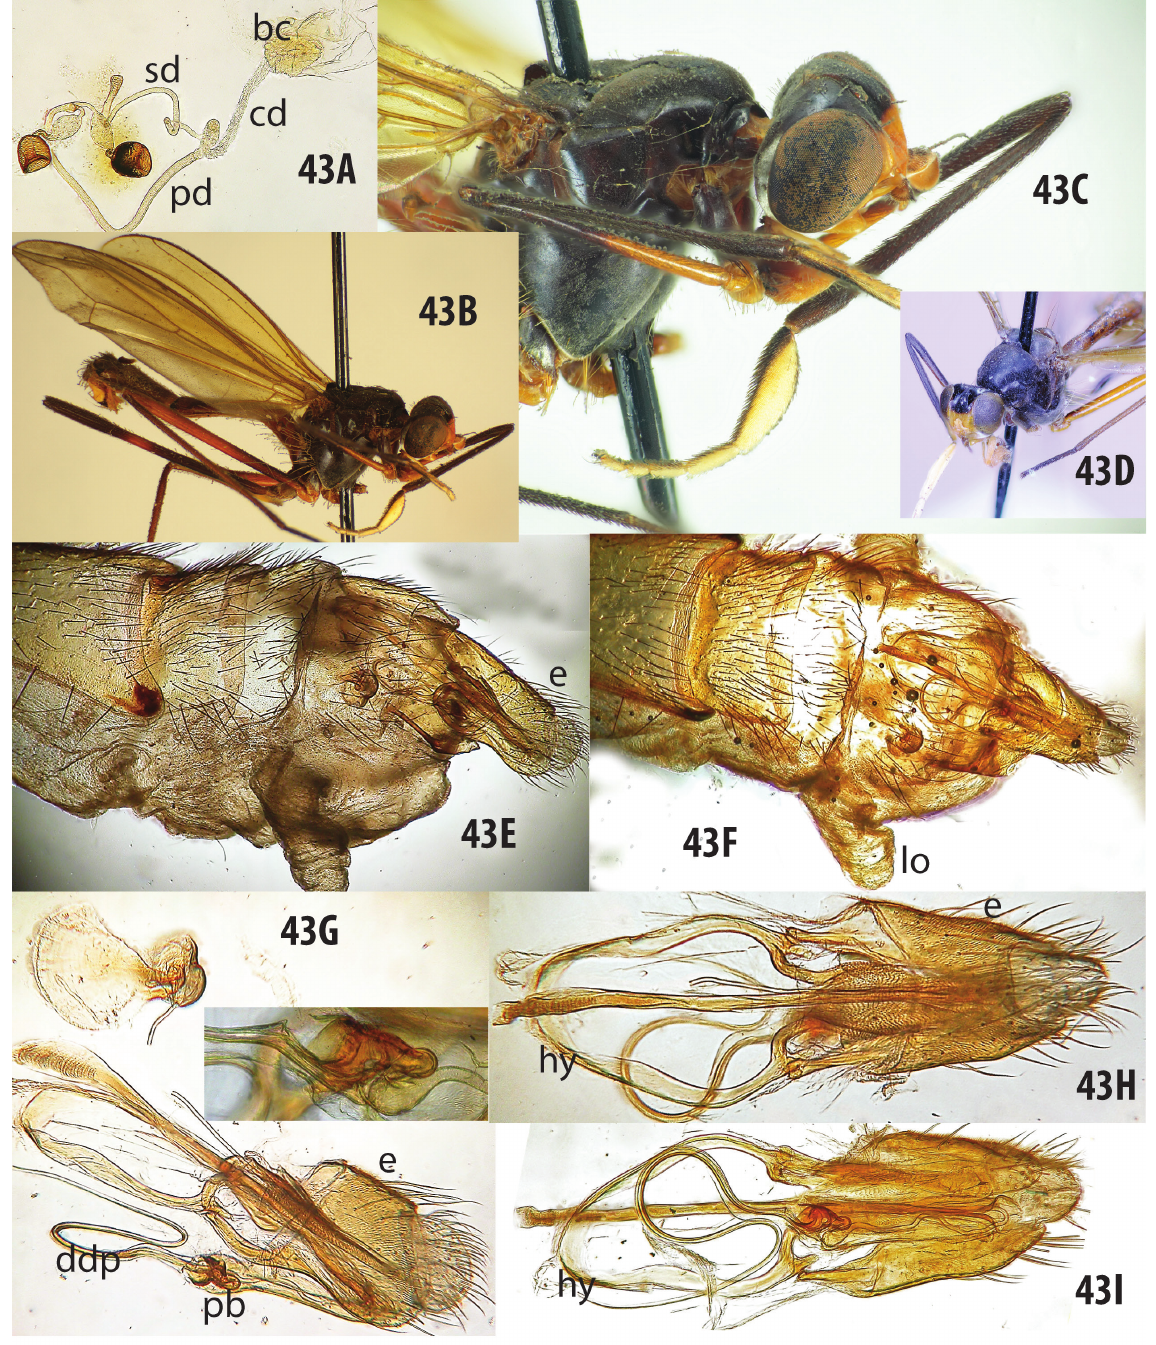
Fig. 43. Mesoconius lobopoda sp. nov. A . Spermathecae and associated structures. B–D . Holotype, ♂, BMNH. E . Abdomen, ♂, left side. F . Abdomen, ♂, ventral view. G . Male terminalia, lateral view, with phallic bulb enlarged in inset. H . Male terminalia, dorsal view. I . Male terminalia, ventral view. Abbreviations: bc = bursa copulatrix; cd = common spermathecal duct; ddp = distal distiphallus; e = epandrium; hy = hypandrium; lo = ʻlobopodʼ pleural lobe of segment 5; pb = phallic bulb; pd = paired spermathecal duct; sd = single spermathecal